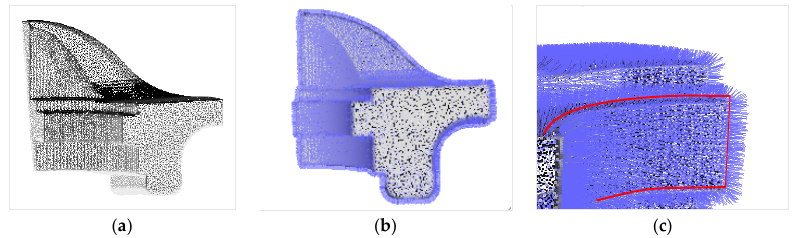
Figure 3. Normal vector of the fandisk model [43]: ( a ) original point cloud; ( b ) normal vectors; and ( c ) locally enlarged display of normal vectors.